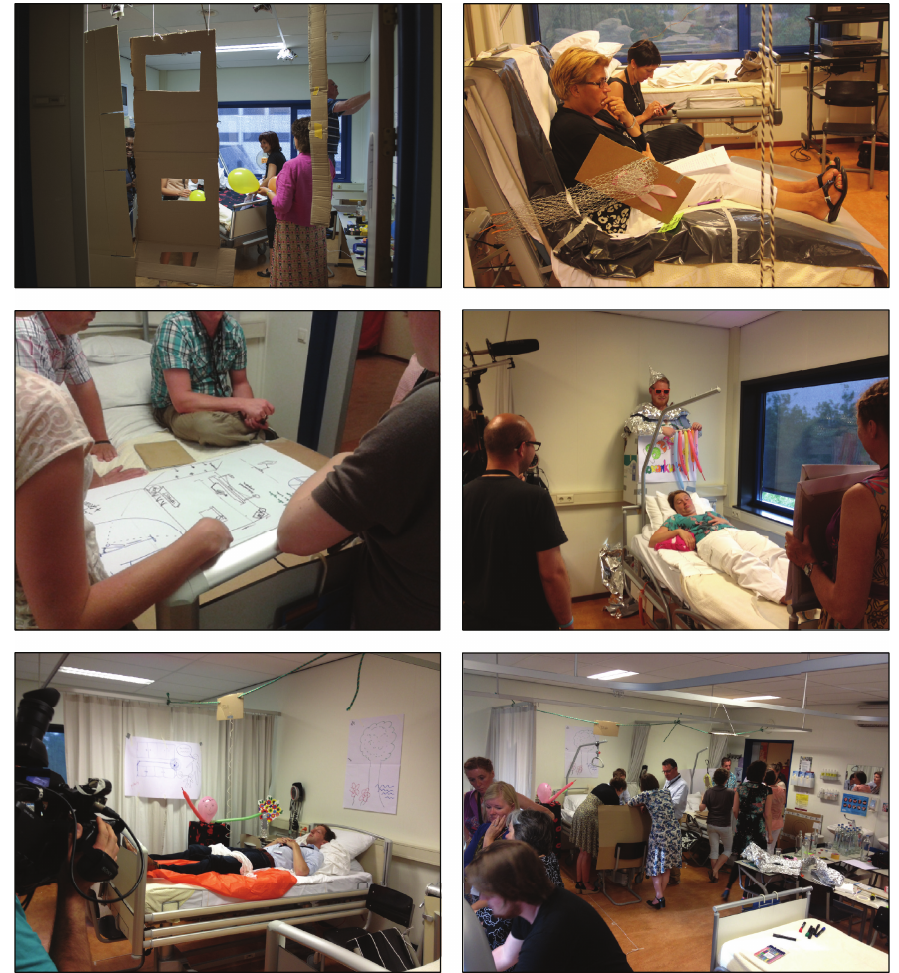
Figure 2: Working together to generate ideas, followed by the enactment and filming of the